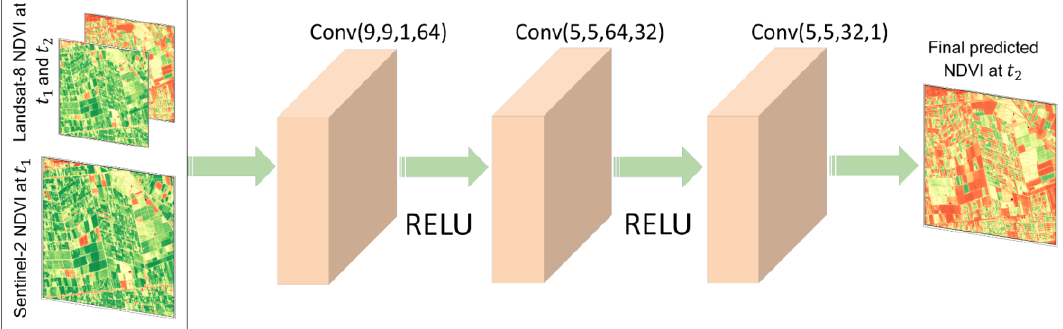
Figure 2. The architecture of the proposed deep convolutional spatiotemporal fusion network method.